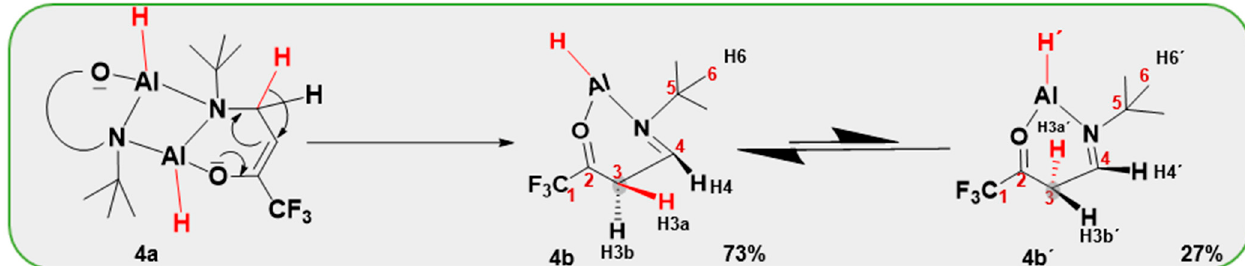
Scheme 5. Proposed hydride shift processes for the formation of the conformation